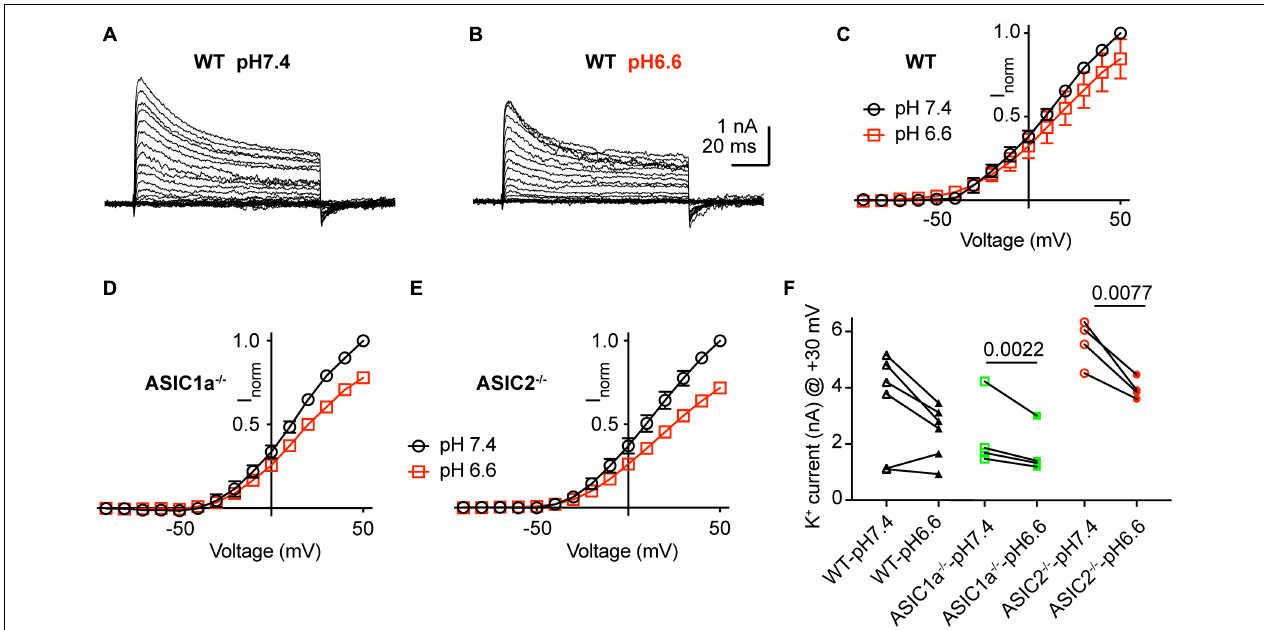
FIGURE 6 | Inhibition of K + currents by acidification to pH6.6. Experiments were done in whole-cell voltage-clamp on cortical neurons. The response to two different solutions was directly compared in the same cell. Only the pH was changed between the two conditions. (A,B) Representative current traces obtained at pH7.4 (A) and pH6.6 (B) from the same neuron. (C–E) I–V curve of K + currents, measured at pH7.4 and pH6.6. Current amplitudes were normalized in each cell to the amplitude measured at pH7.4 at + 50 mV. (C) Neurons from WT mice, n = 6, (D) ASIC1a − / − mice, n = 4 and (E) ASIC2 − / − mice, n = 4. (F) Peak K + current amplitudes measured at + 30 mV, at pH7.4 and 6.6, from WT, ASIC1a − / − and ASIC2 − / − cortical neurons, n = 4–6. P -values obtained with paired t -tests are indicated in (F) if they were <